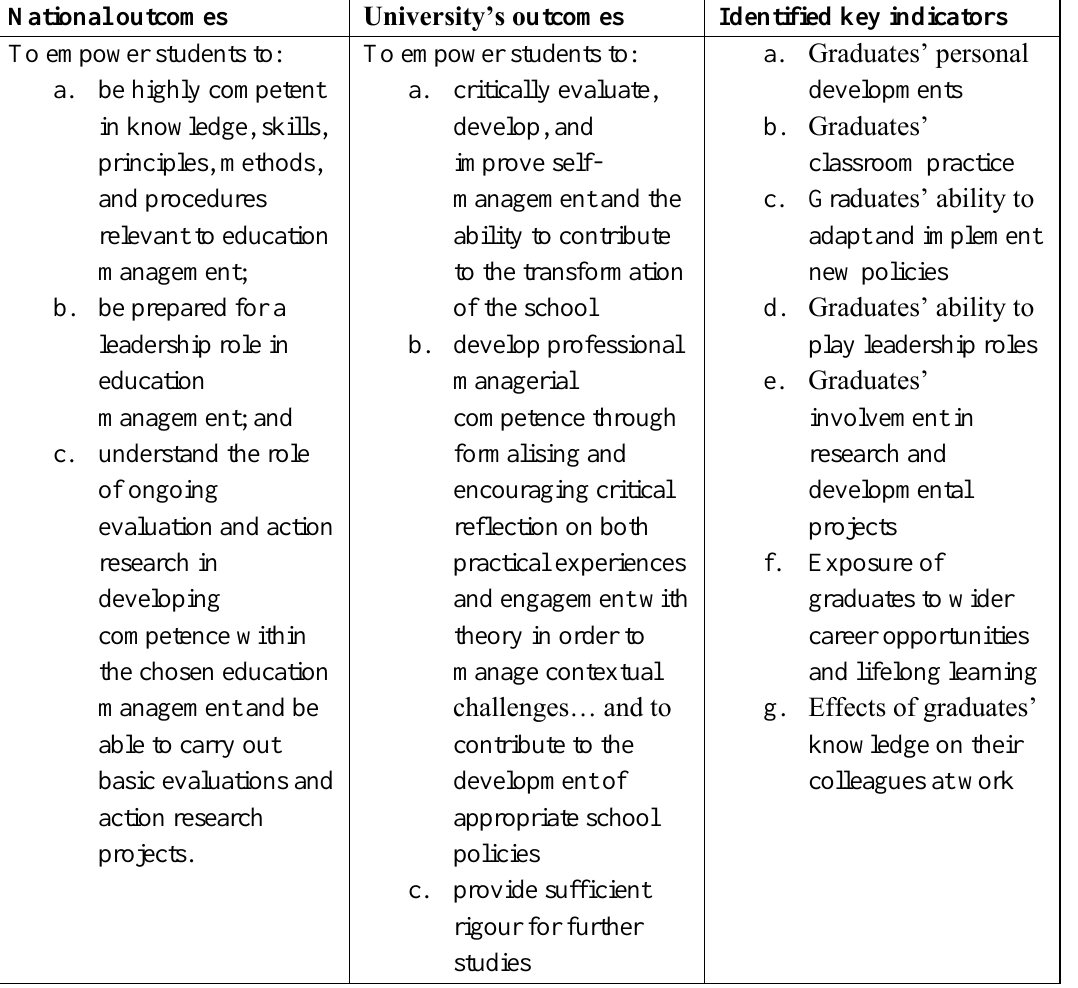
Table 2 Content Validity of Instruments (Based on the Outcomes of the Program) National outcomes University’s outcomes Identified key indicators To empower students